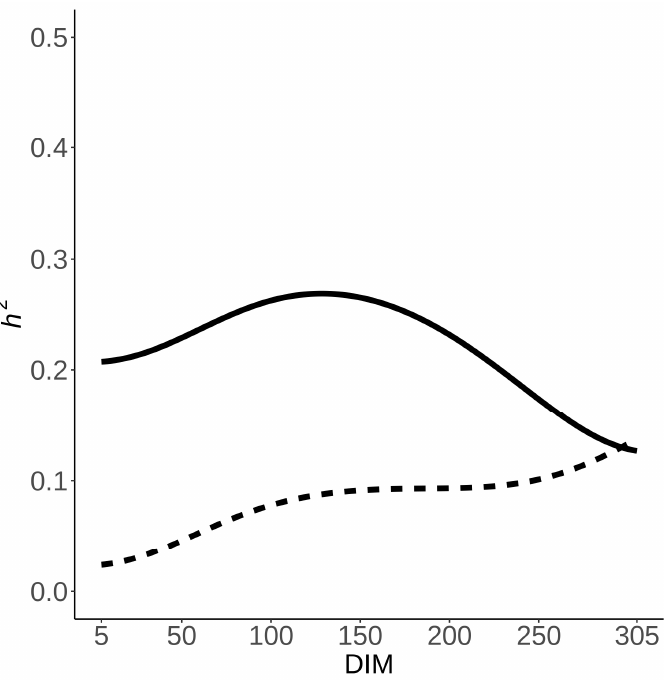
Figure 3. Heritability estimates for CH 4 ppm/d (dashed) and CH 4 g/d (solid) throughout lactation.